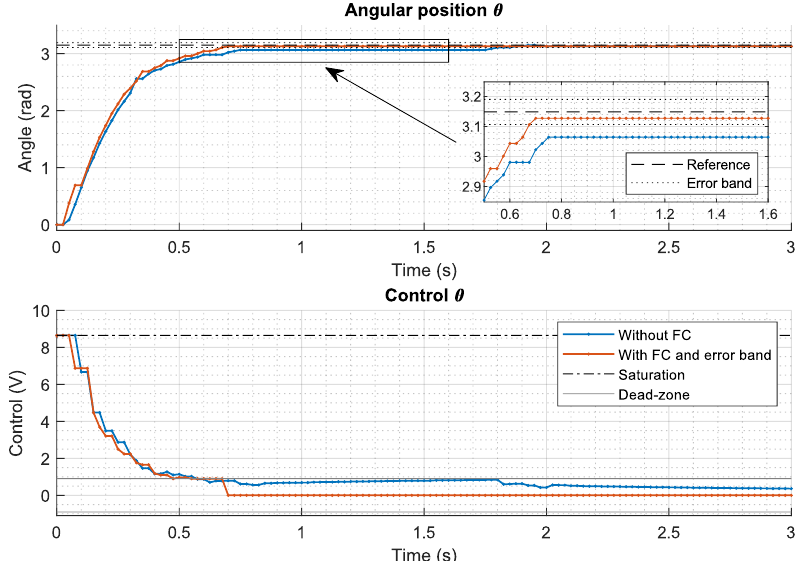
Figure 20. Back-right wheel experimental results with and without friction compensator plus er- ror